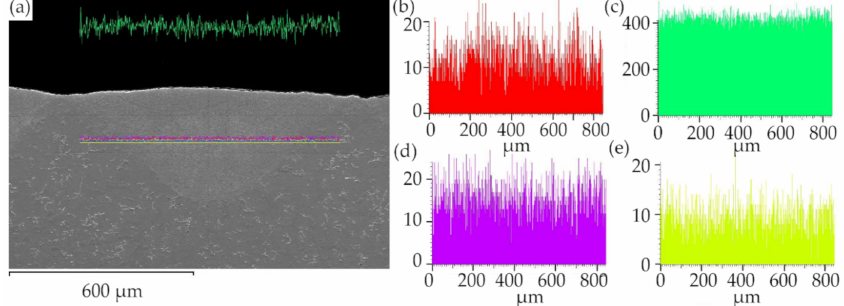
Figure 8. Line scan element analysis along the surface of laser-processed layer: ( a ) place of line scan in cross-section of layer; ( b ) C distribution; ( c ) Fe distribution; ( d ) Si distribution; ( e ) Mn distribution.